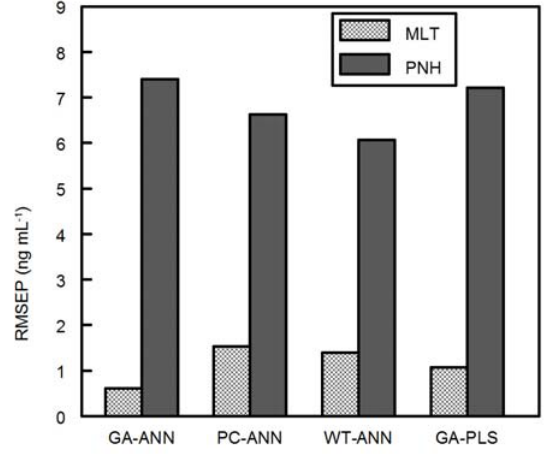
Figure 9. Bar plots for comparison of the RMSEP values obtained by application of the proposed multivariate calibration methods for the analysis of validation